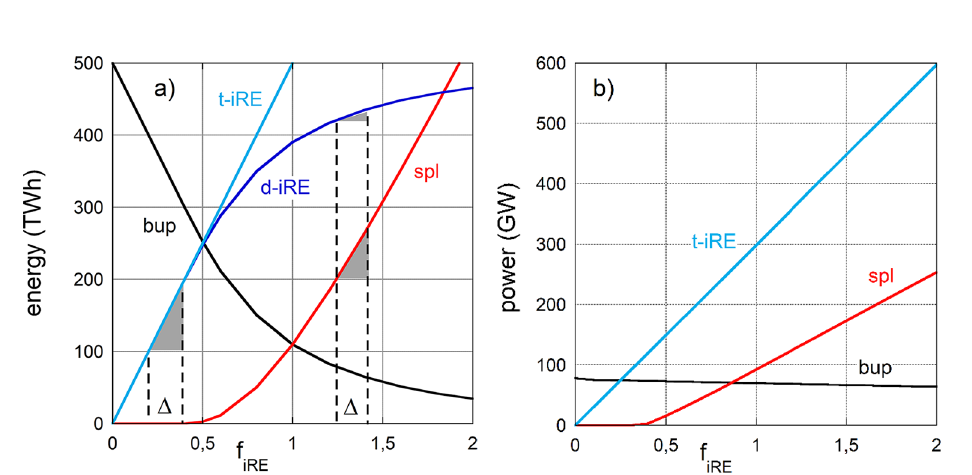
Fig. 6. – (a) Energy generation vs. the normalised intermittent iRE share, f iRE = E W+PV /T a , for the conditions of 2019. This relation is shown for the total iRE generation, (t-iRE), the directly usable iRE share, (d-iRE), the surplus generation (spl), and the backup energy (bup). The triangles indicate how an increment Δ in wind+PV generation leads to an increase in d- iRE in the linear range of this curve and how d-iRE and spl share the increase in the saturation range. (b) Corresponding